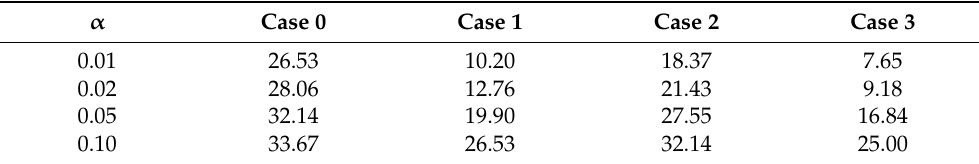
Table 16. The Numbers of SSCRs in Percentage of All CRs for Considered Study Cases for Different Values of the Significance Level α